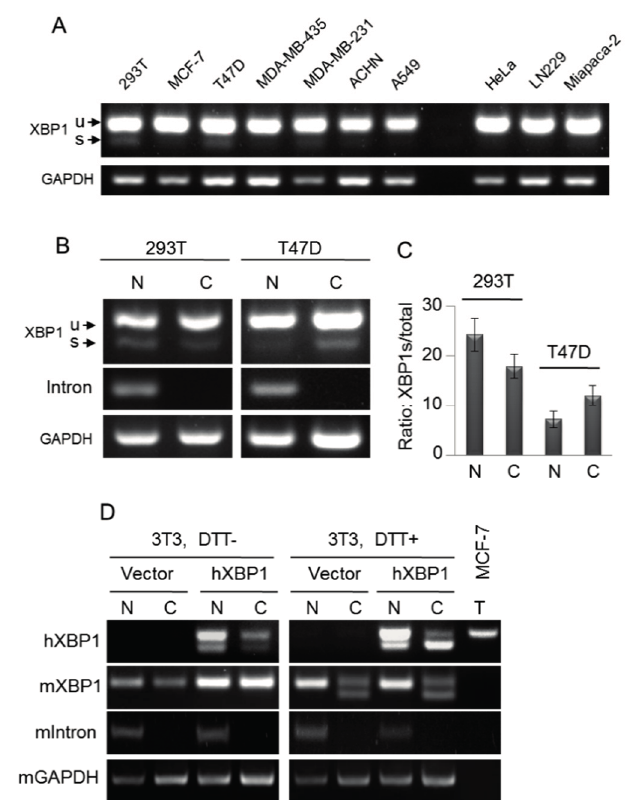
Figure 4. Occurrence of the unconventional splicing of endogenous XBP1 mRNA in the nucleus. ( A ) Cells were cultured in the normal condition. The total RNA was subjected to RT-PCR with XBP1 primers; ( B ) 293T and T47D cells were cultured in the normal condition, and then were fractioned. The fractioned RNA was subjected to RT-PCR with XBP1 primers; ( C ) Quantified fractions of nuclear spliced XBP1 mRNA in 293T and T47D cells, the ratio of spliced XBP1 mRNA to total XBP1 mRNA. Data are from three independent experiments as described in ( B ). Error bars show means ± SD; and ( D ) Human XBP1 (hXBP1) was stably expressed in mouse 3T3 cells. Cells were treated with 1 mM